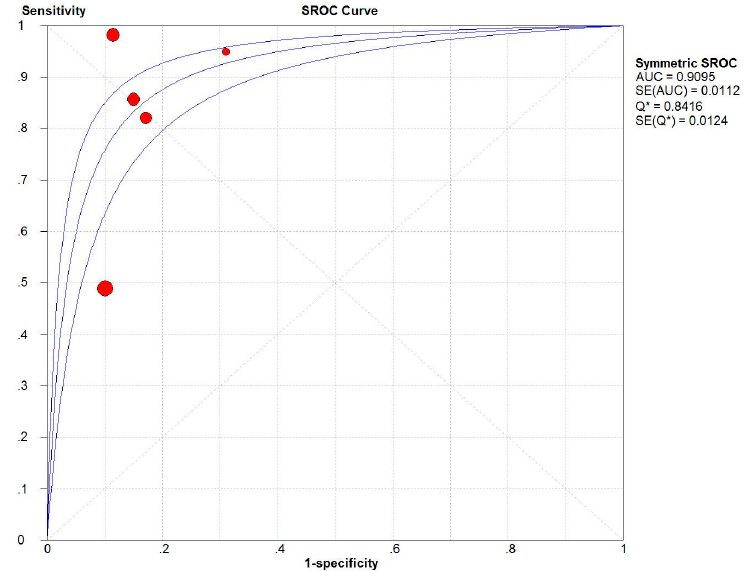
Figure 3. Summary receiver operating characteristics (SROC) curve of the New Injury Severity Score (NISS). AUC is the area under the receiver operator characteristic (ROC) curve.